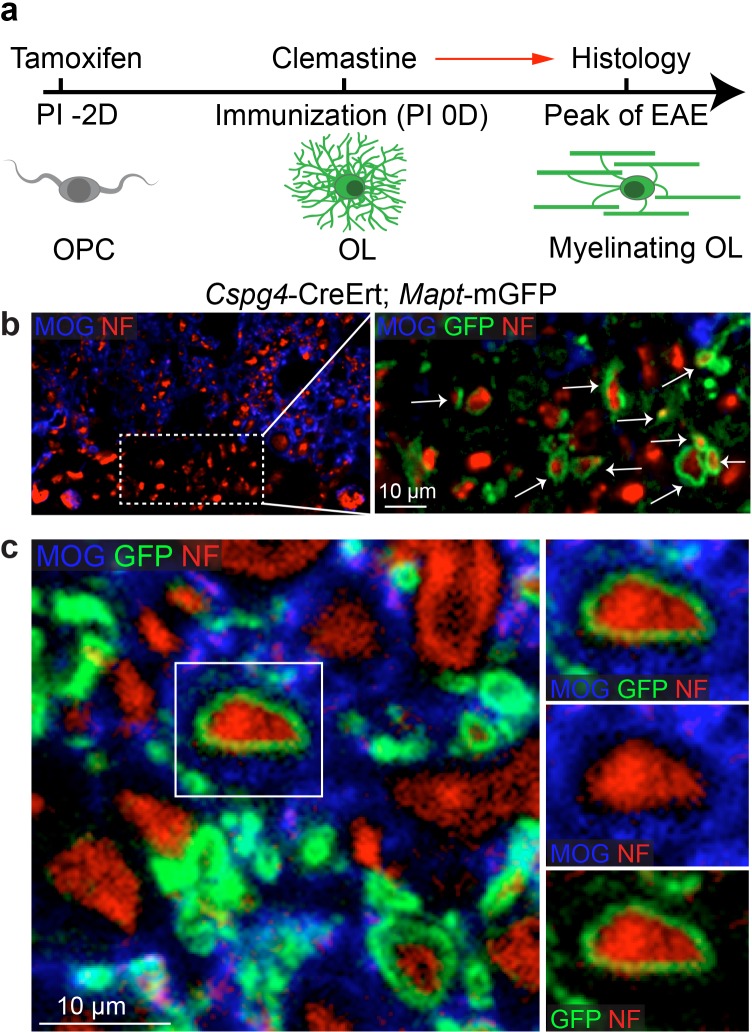
Lineage-specific tracing of remyelination by newly-formed oligodendrocytes in EAE.Lineage-specific tracing of remyelination by newly-formed oligodendrocytes was accomplished using the Cspg4-CreErt; Mapt-mGFP line. Recombination is induced by a single dose of tamoxifen in NG2 cells (OPCs), two days prior to immunization and clemastine administration (a). As OPCs do not express tau, only the newly differentiated OLs express mGFP. (b) MOG and NF immunostaining display a number of GFP positive myelin sheaths wrapping demyelinated axons (NF+/MOG-) after clemastine treatment. Additionally, a number of axons undergoing remyelination are surrounded by thin GFP membrane that are still yet negative for MOG expression (c).